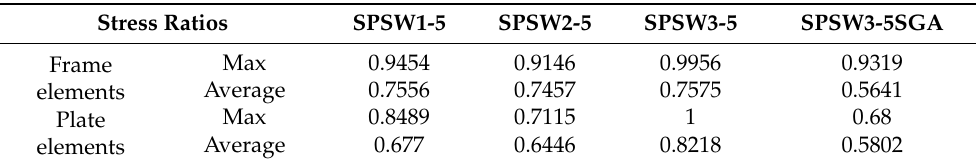
Table 7. Maximum and average stress ratios of the frame and plate elements for structures with a 5-story steel frame.